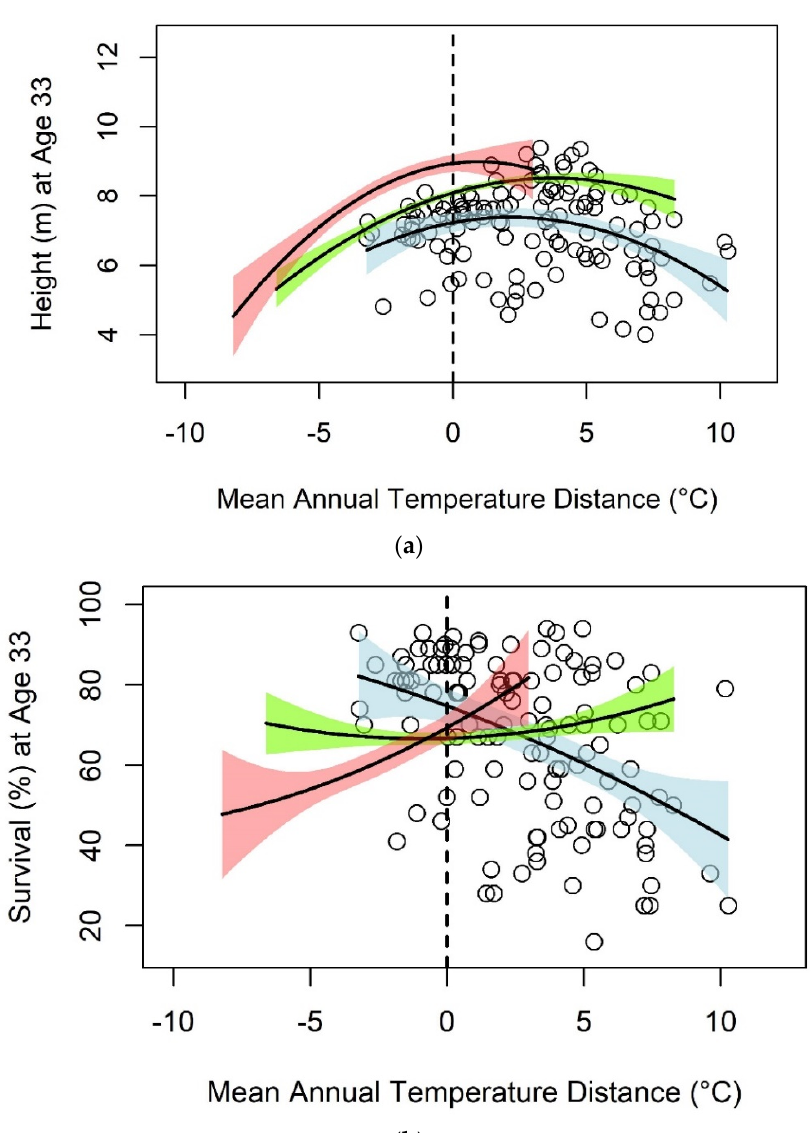
Figure 3. Relationship between mean annual temperature and ( a ) height and ( b ) survival of black spruce seed sources at 33 years of age. Separate regression lines and 95% confidence intervals are shown for southern (red), central (green), and northern (blue) seed sources. Data points (black circles) are shown only for northern seed sources. The vertical dashed line indicates local deployment of seed sources (i.e., a transfer distance of zero); points to the right of this line indicate seed transfers to warmer planting sites and vice versa.